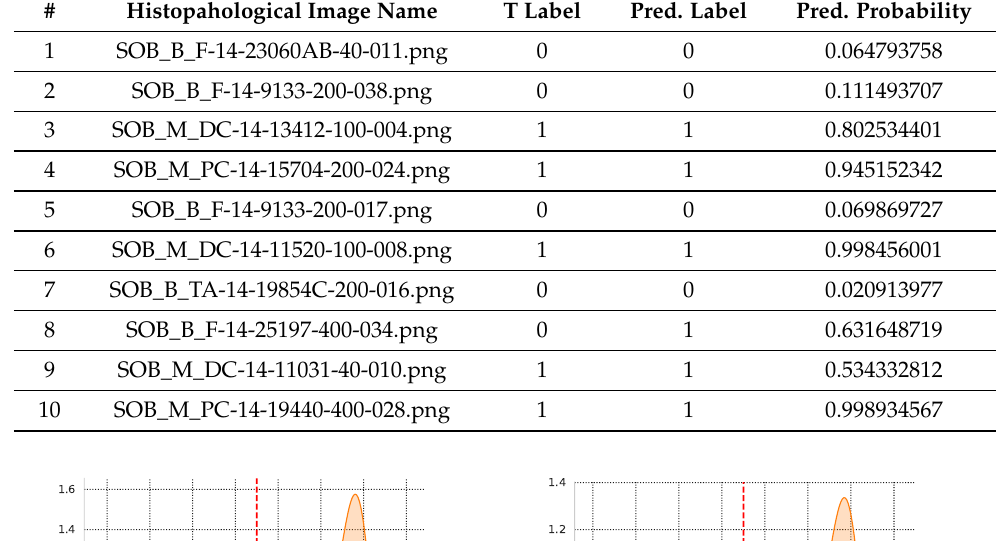
Table 3. Prediction probabilities for randomly selected samples from testing dataset.